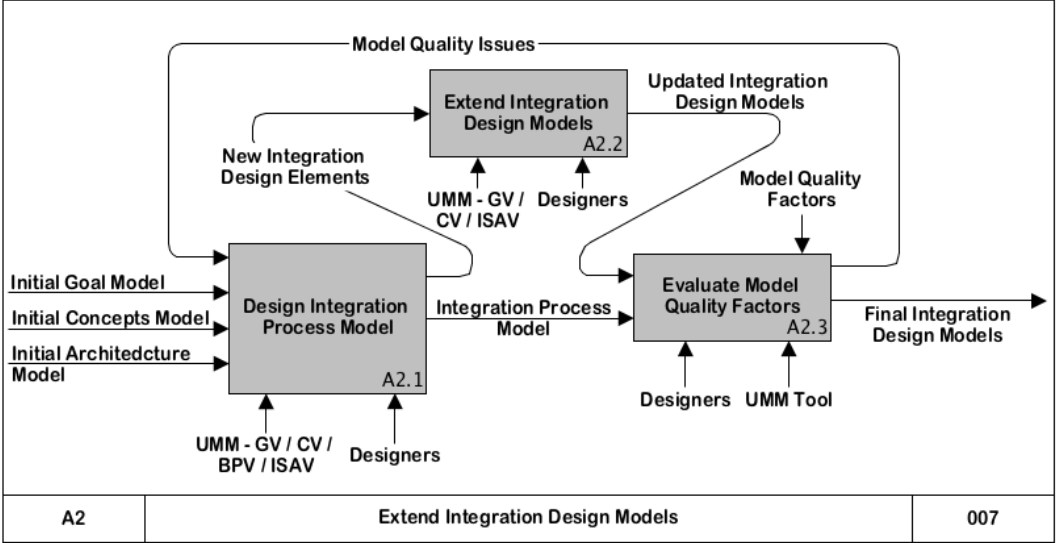
Figure 4. Details of the second stage of the methodology. Level A2 of the IDEF0 notation